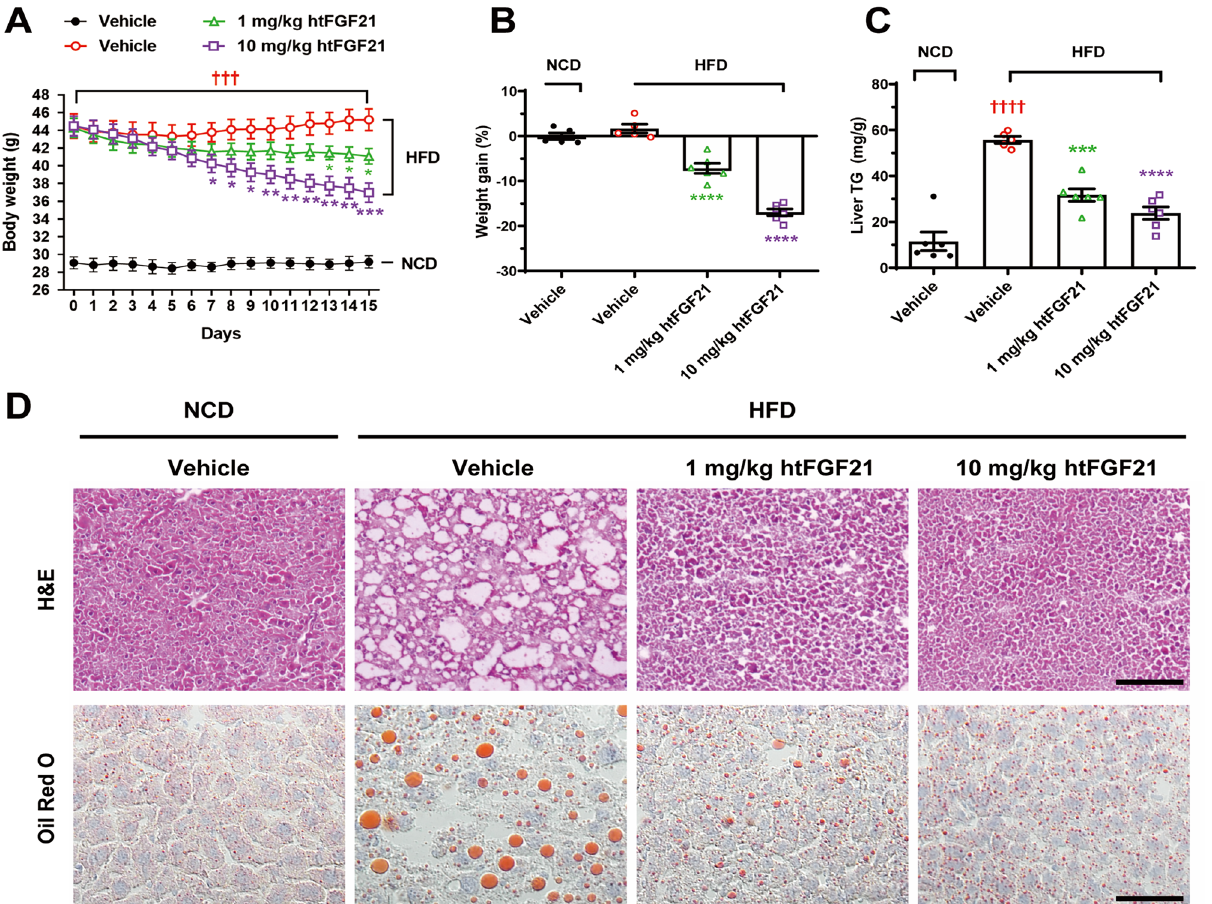
Figure 5. In vivo activity tests of htFGF21. HFD-fed mice were injected with htFGF21 intraperitoneally at doses of 0 (vehicle), 1, or 10 mg/kg once daily for 14 days. NCD-fed mice were included as controls and injected intraperitoneally with vehicles. ( A ) Changes in body weight throughout the injection. ( B ) Percent weight gains on the following day after the last injection. ( C ) Effects of the injection on liver TG contents. ( D ) H&E and Oil Red O staining of liver sections showing reversal of vacuolation and lipid accumulation in htFGF21-injected HFD-fed mice. Data are represented as mean ± SEM, calculated using one-way ANOVA followed by Tukey’s multiple comparisons test, * p < 0.05, ** p < 0.01, *** and ††† p < 0.001, **** and †††† p < 0.0001. n = 5–6 mice/group. ††† and †††† indicate vehicle-injected NCD-fed mice versus vehicle-injected HFD-fed mice. *, **, ***, and **** indicate vehicle-injected HFD-fed mice versus htFGF21-injected HFD-fed mice. Scale bars: 100 μm (H&E), 50 μm (Oil Red